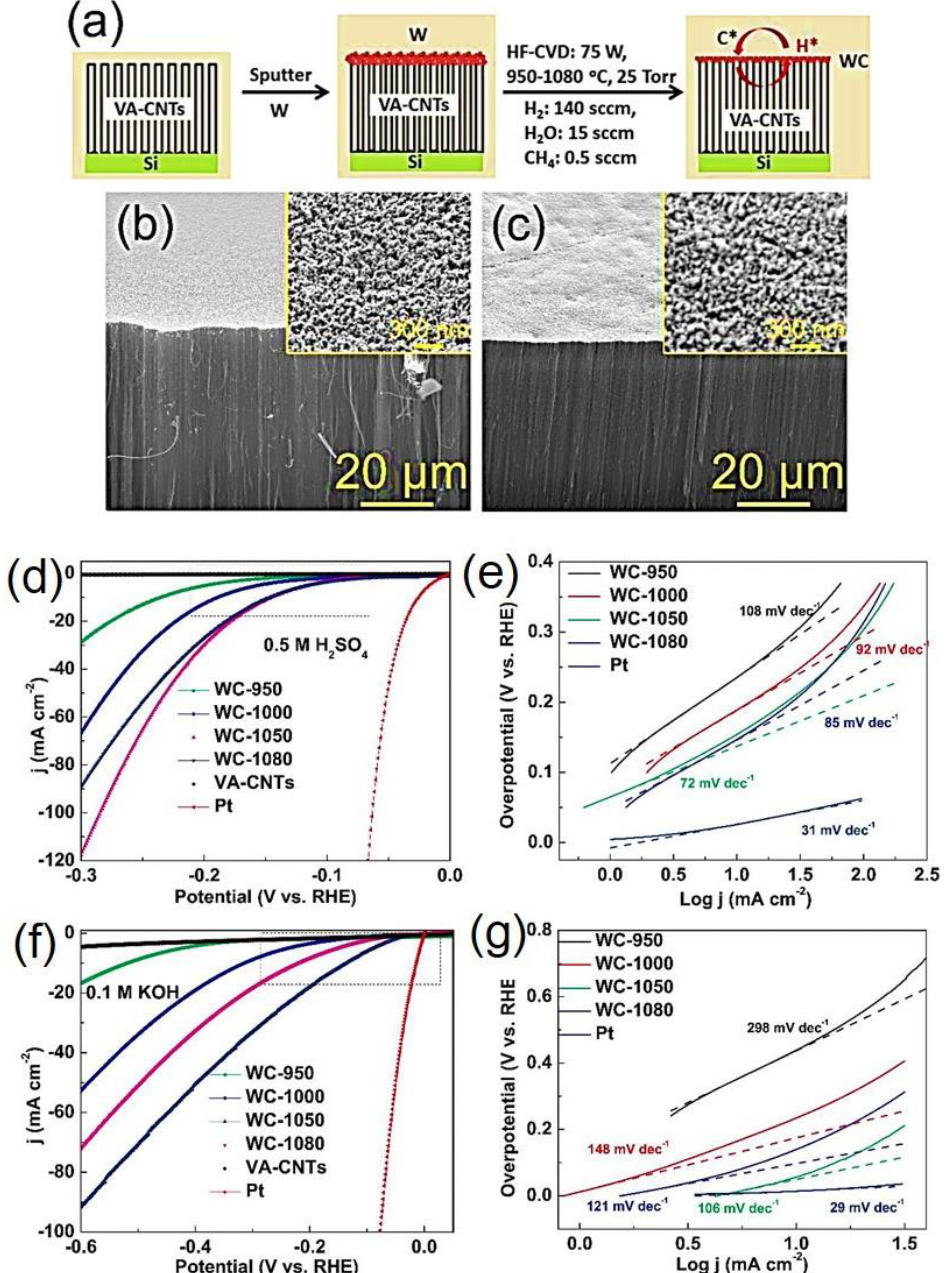
Figure 6. ( a ) Schematic of the formation of WC nanocrystals over VA-CNTs, ( b , c ) Field-emission SEM image of bare VA-CNT and WC nanocrystals over VA-CNT that formed at 1050 °C for 6 h, ( d , e ) LSV and Tafel slope plots of WC nanocrystals over VA-CNT at different temperatures in an acidic medium, ( f , g ) LSV and Tafel slope plots of WC nanocrystals over VA-CNT at different temperatures in an alkaline medium [94] . Copyright 2015 The American Chemical Society.